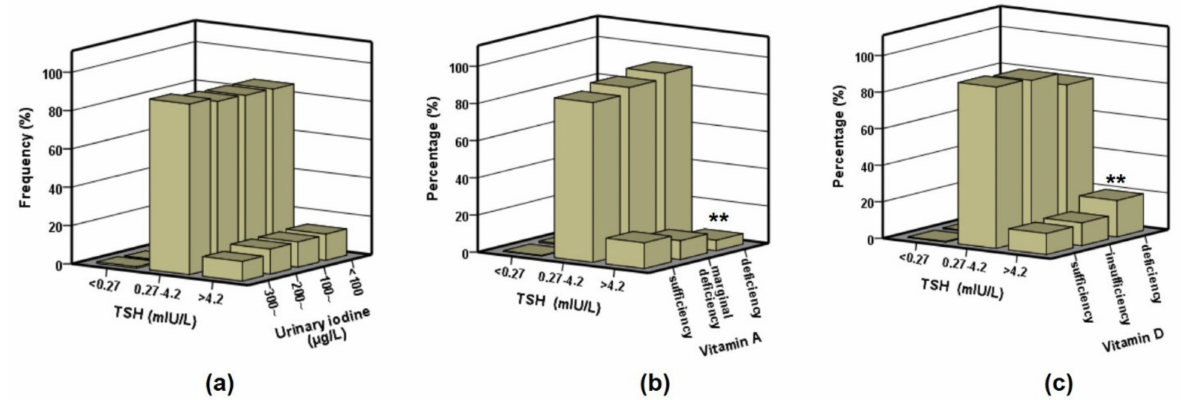
Figure 1. Distribution of TSH in different UIC, vitamin A and vitamin D groups. ( a ) TSH distribution in each UI group (<100, 100~, 200~, and 300~ µ g/L); ( b ) TSH distribution in each VA group (deficiency, marginal deficiency, sufficiency); ( c ) TSH distribution in each VD group (deficiency, insufficiency, sufficiency). Values are percentage. Statistical differences to the sufficiency groups are shown as ** p <